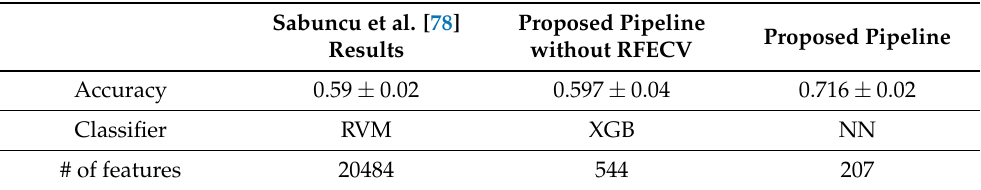
Table 3. The classification accuracy score of the Sabuncu et al. study, and the proposed model with and without RFECV, along with the classifier used to achieve the score for each model and the number of features included in each model.